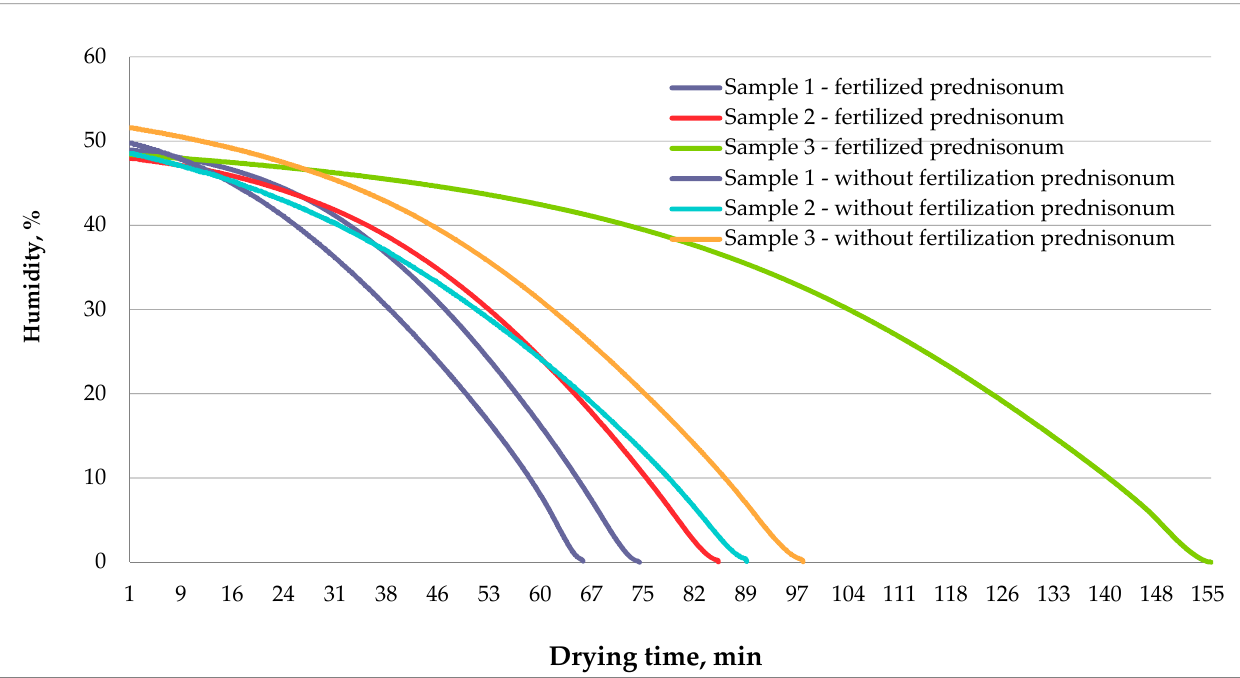
Figure 6. Drying curve for energy willow samples.